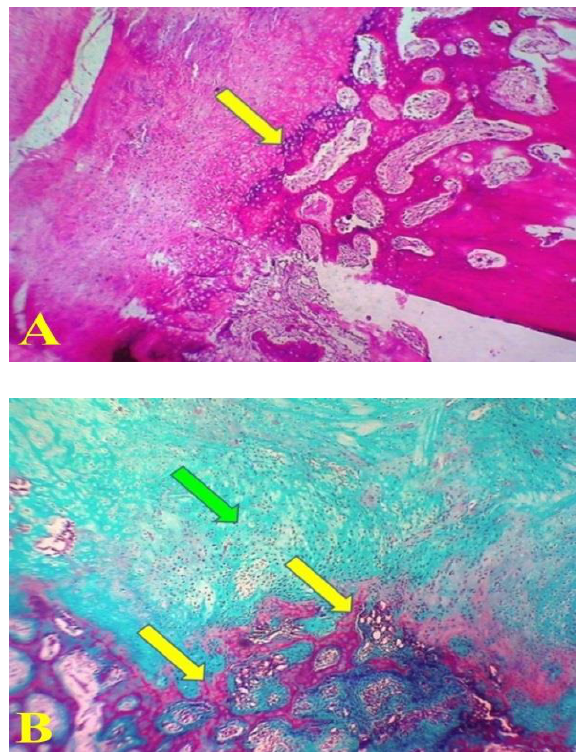
fractured linked by fibrocartilaginous tissue with few ossifications of some cartilage cells, (Fig. 4: A and B).